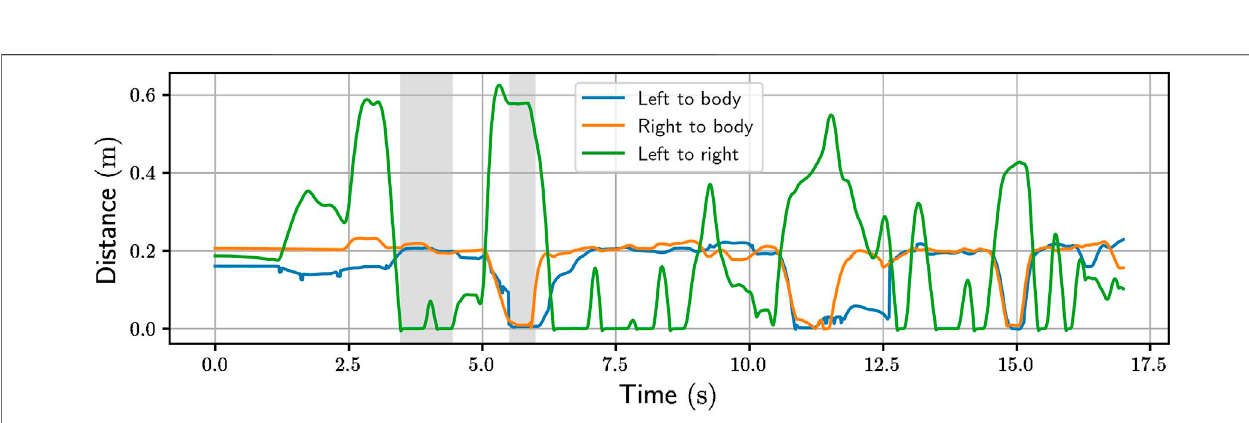
FIGURE5| ShortestdistancesbetweenthecollisionsurfacesofthePARTIsystem ’ sleftandrightendeffectorsaswellasthemainbodyduringthe fi rstexperiment. Theconstraintforcesfromthesimulatorappliedtothephysicalsystempreventthecollisionmeshesfromintersecting,i.e.thedistancesremaingreaterorequalto0.Note that the sections highlighted in grey mark active attempts by the operator to bring the respective bodies into